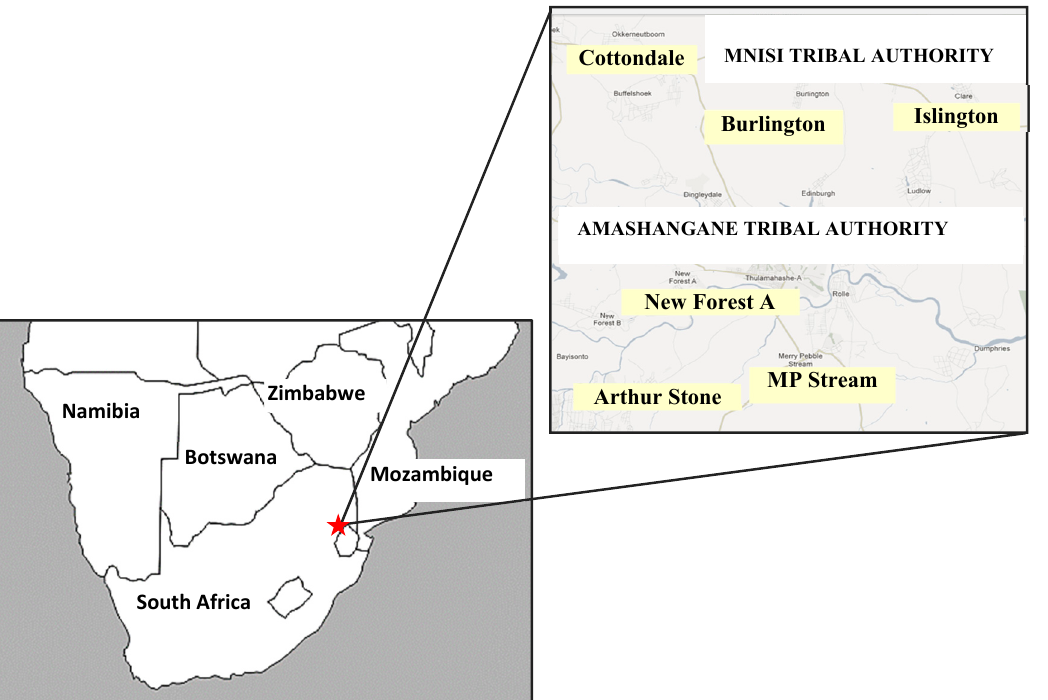
Figure 1. A map of the six study villages in the Bushbuckridge region, South Africa.